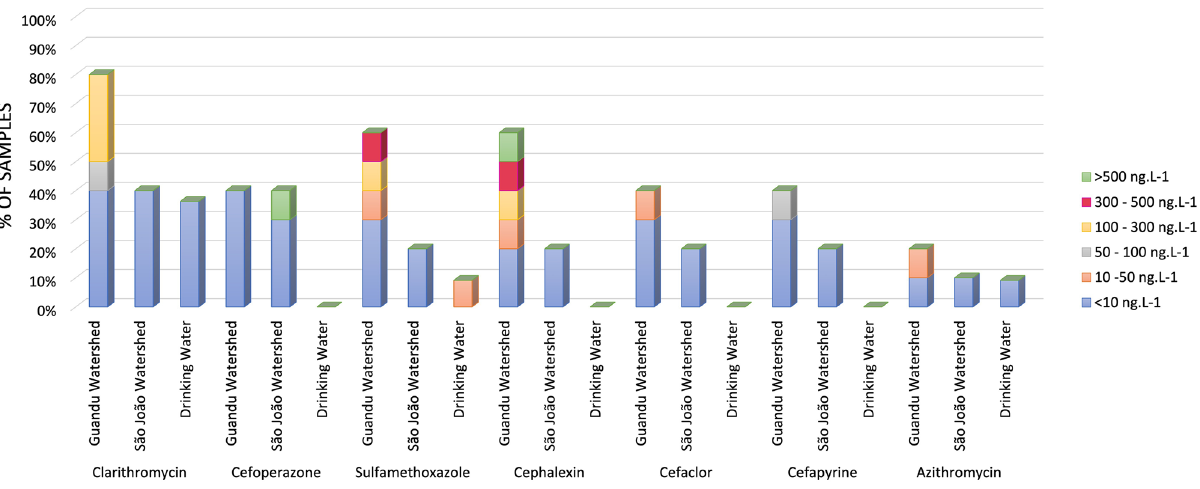
Figure 1. Detection frequency and concentration levels of antimicrobials in grouped samples of São João watershed, Guandu watershed, and Drinking